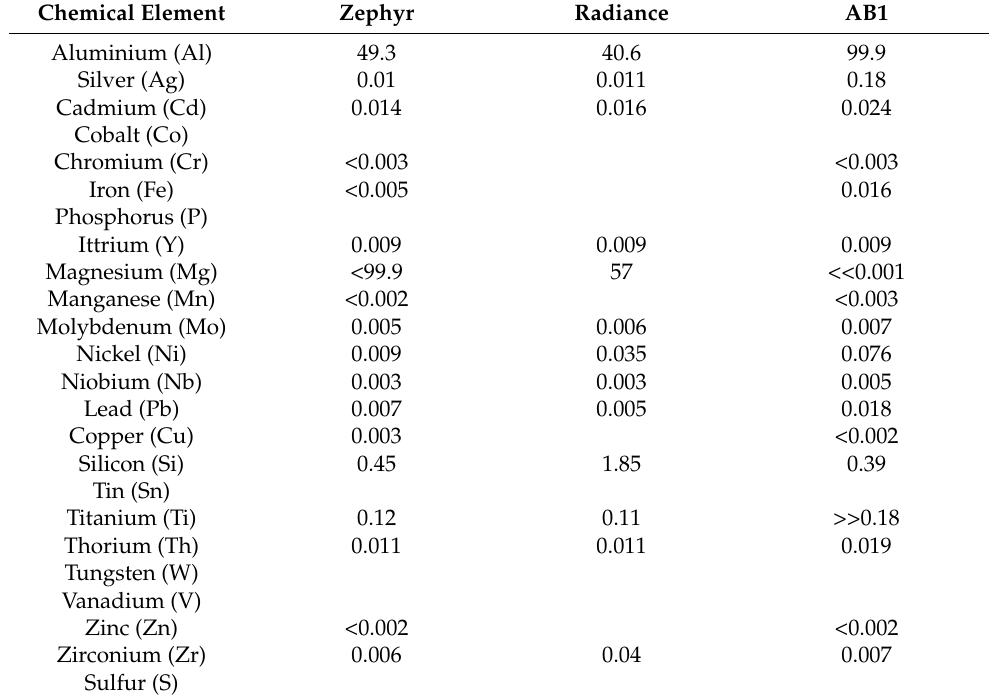
Table 7. Overall rating of the aesthetic brackets.